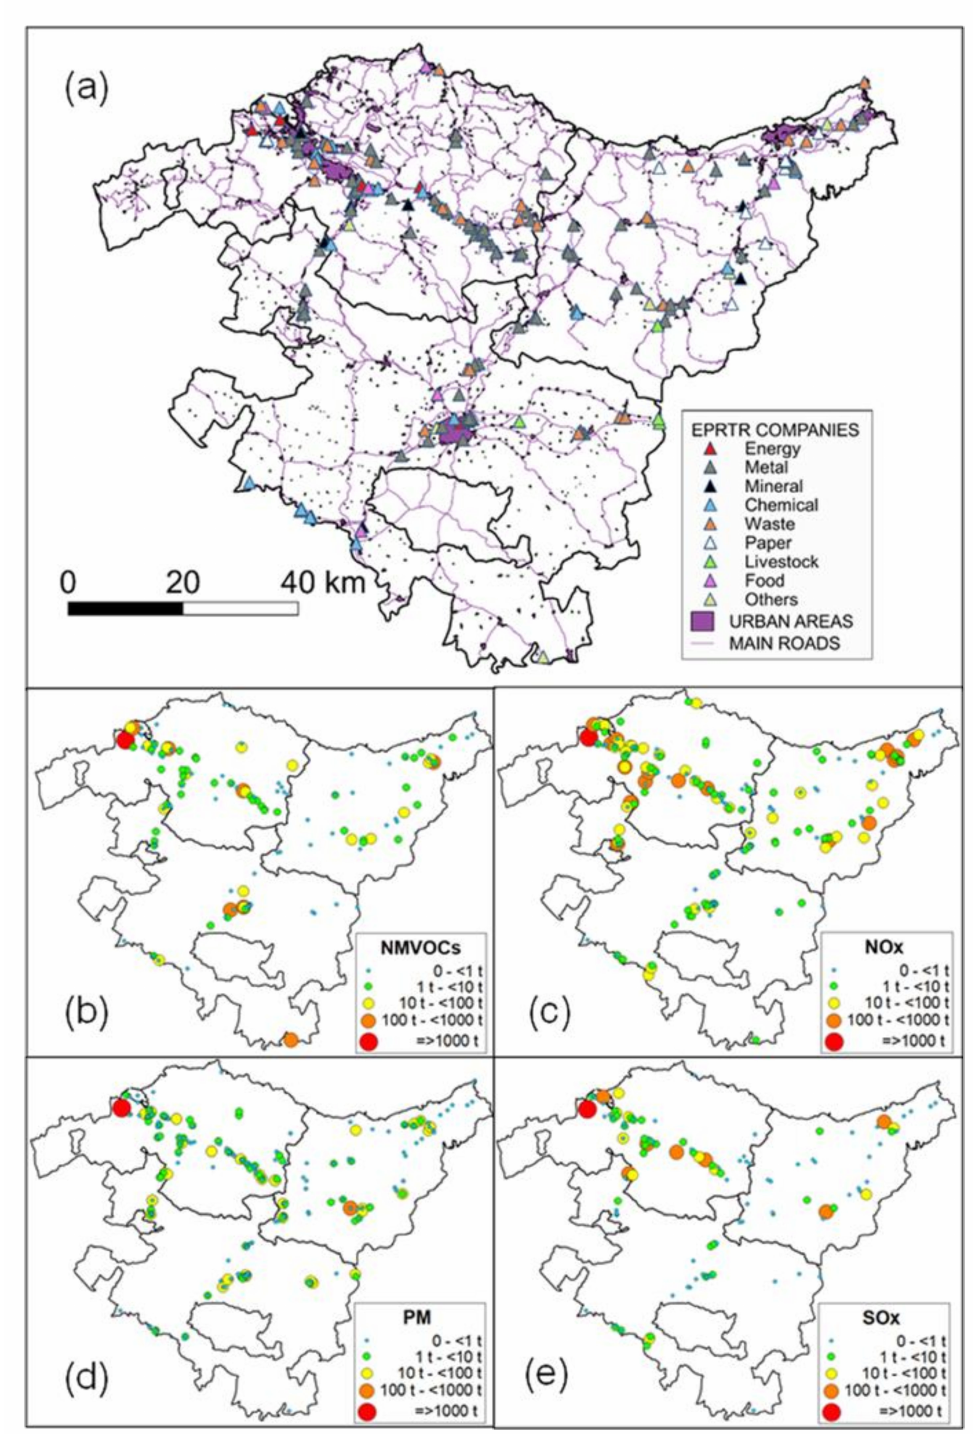
Figure 2. ( a ) Location of the companies registered in the European Pollutant Release and Transfer Register (EPRTR), Basque Country (2018), main urban areas, and roads. ( b – e ) Estimated annual emissions of NMVOC, NOx, PM, and SOx, respectively, from companies registered in the EPRTR. To assess the impact of the lockdown restrictions on the air pollution of the three provincial capitals, a selection of urban background sites and traffic stations was made, following the European Environmental Agency (EEA) criteria. This organization uses a viewer that tracks the weekly and monthly average concentrations of NO 2 and